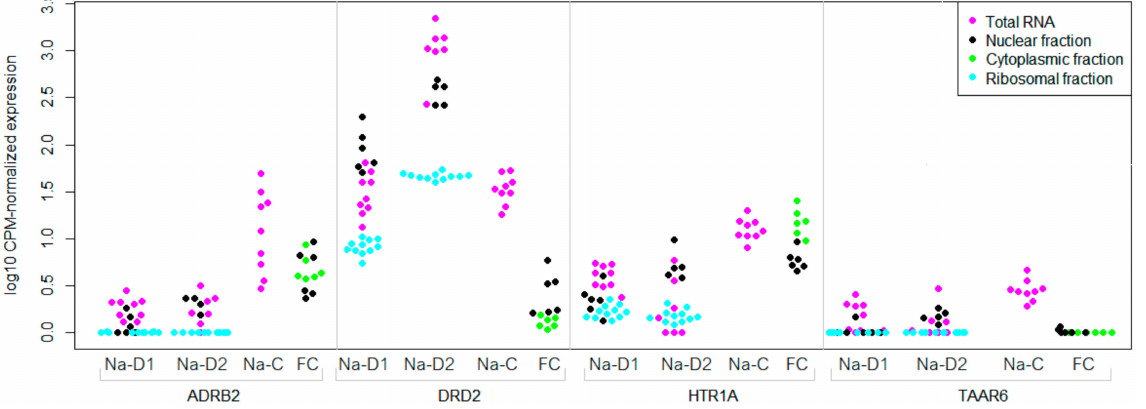
Figure 3. Expression levels of TAAR6, DRD2, ADRB2, and HTR1A in the subcellular structures in the mouse nucleus accumbens (GSE121199 and GSE130376) and human frontal cortex (GSE110727). Na-D1—expression in the D1 dopamine receptor positive medium spiny neurons of the nucleus accumbens, Na-D2—expression in the D2 dopamine receptor positive medium spiny neurons of the nucleus accumbens, Na-C—expression in the cholinergic neurons of the nucleus accumbens, FC—expression in the subcellular structures of the human frontal